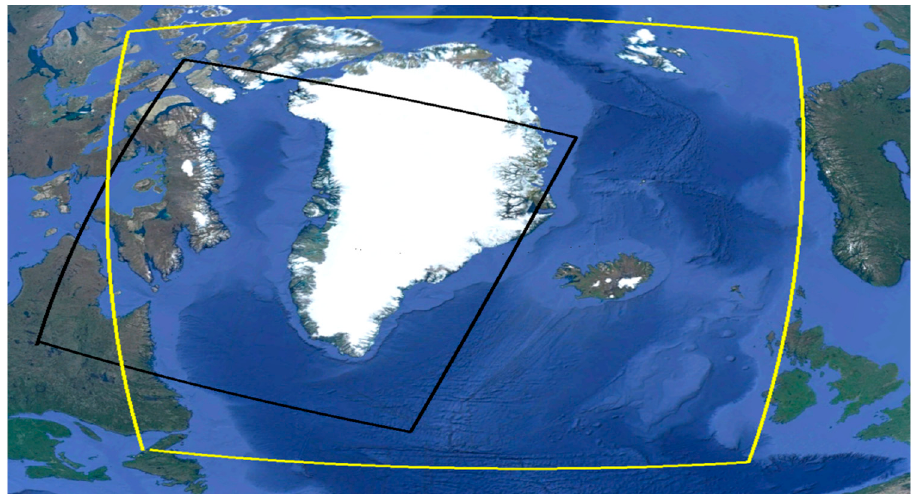
Figure 2. Horizontal domains of the Polar WRF run operationally during PW1 (black) and the research WRF model that was run post PW2 to study barrier winds (yellow).